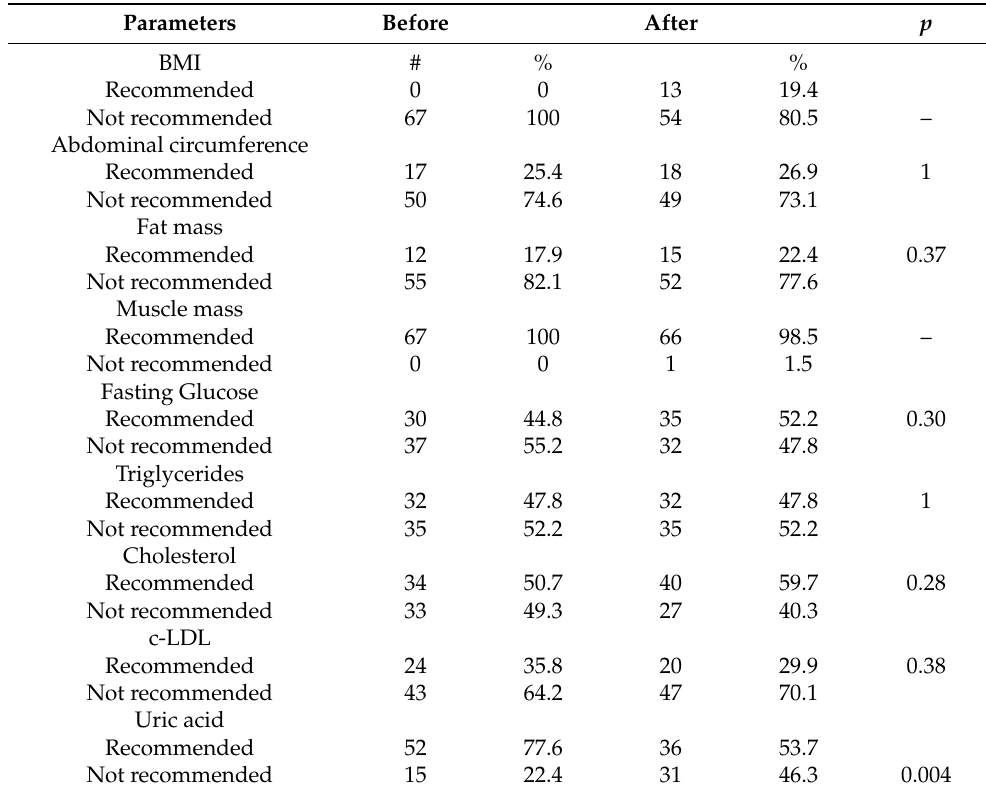
Table 3. Parameters recommended for metabolic control before and after inulin intervention in T2DM